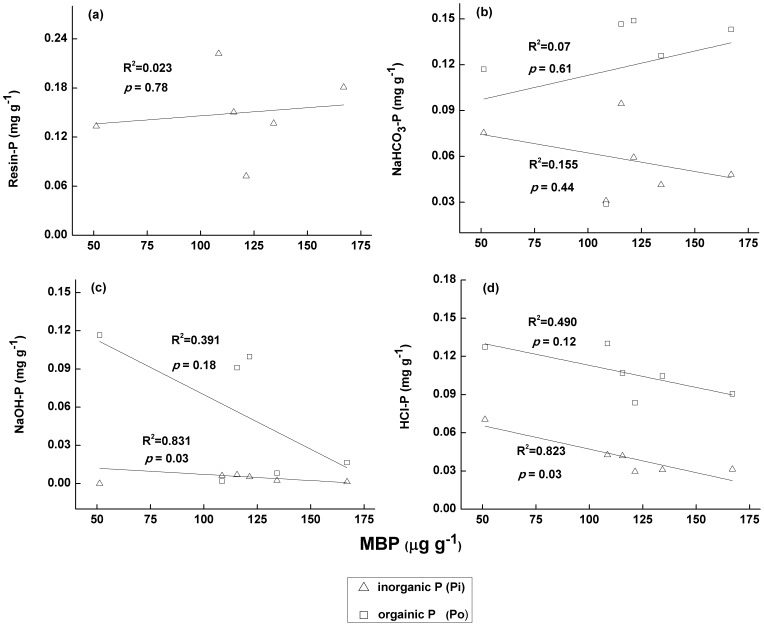
Relationships between MBP and phosphorus speciation on Mount Gongga.(a) MBP vs. Resin-P; (b) MBP vs. NaHCO3-P; (c) MBP vs. NaOH-P; and (d) MBP vs. HCl-P. The lines represent linear model fits.